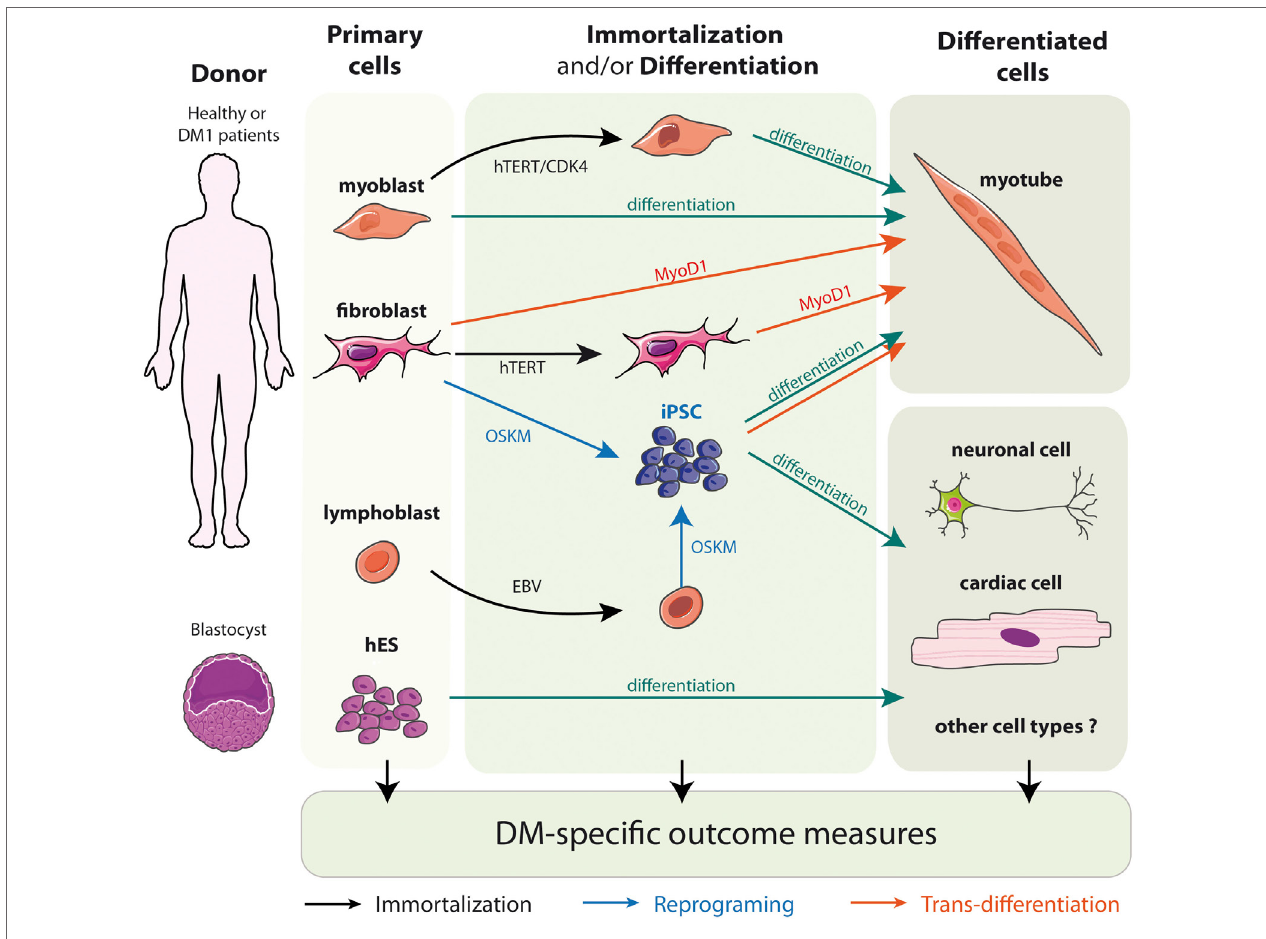
FiGURe 2 | Models of DM1 patients’ derived